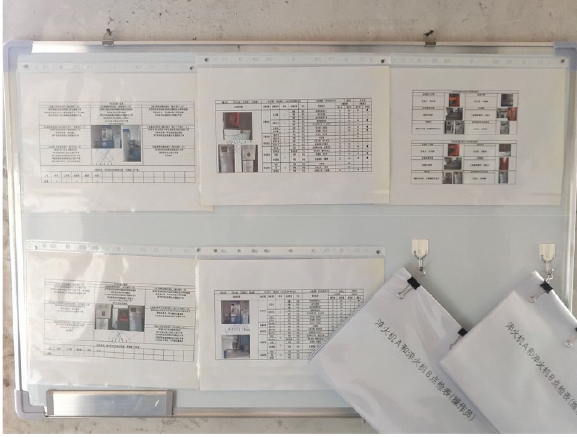
Figure 9. The whiteboard for five key equipment